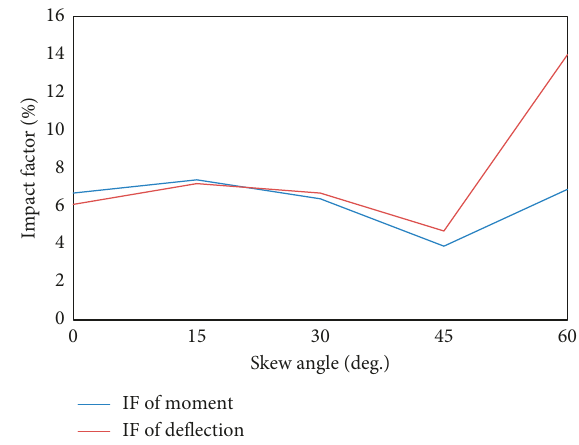
Figure 9: Effect of skew angle on the dynamic impact factors of Bridge A-6.